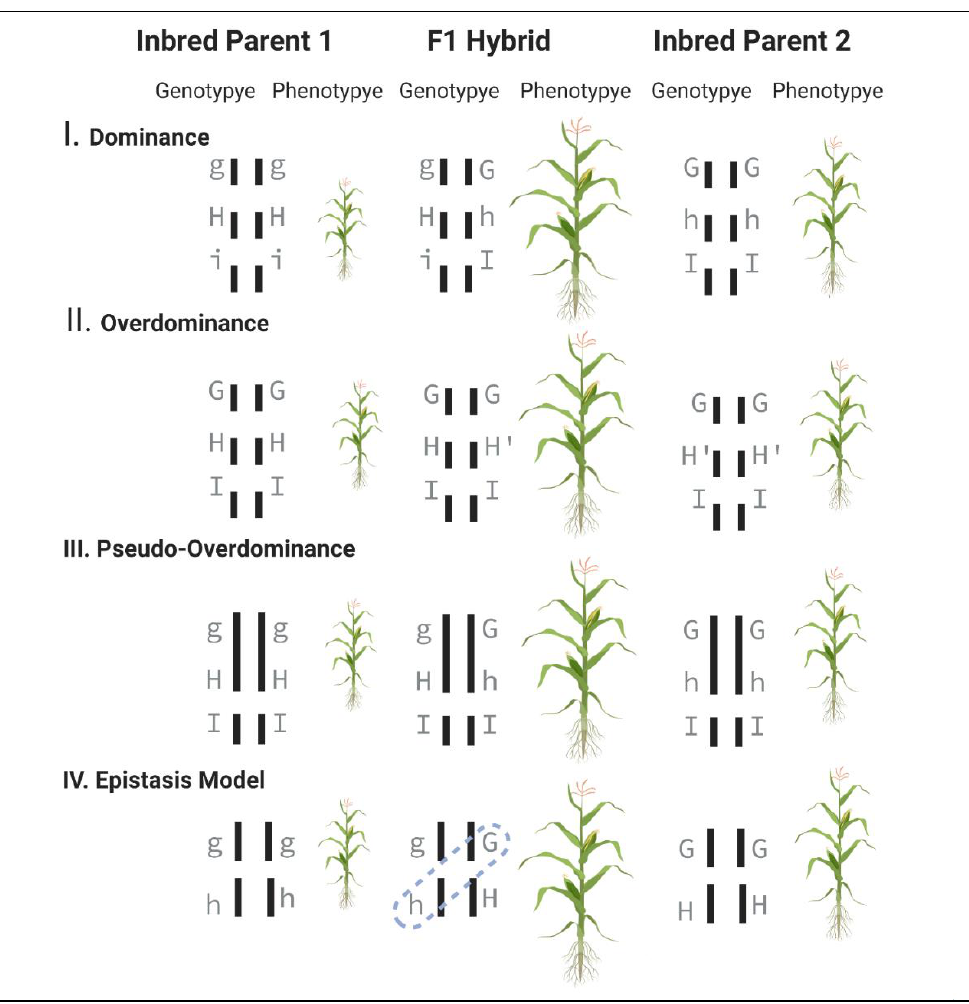
Figure 2. Genetic models for heterosis. Diagrams represent that the hypothetical phenotype or trait is influenced by multiple linked or unlinked loci (e.g., ‘g’, ‘h’, ‘i’). (I) Dominance Model : Inbred parents 1 and 2 exhibit marginally deleterious alleles in homozygous form (g and i in parent 1; h in parent 2). In F1 hybrid, complementation of superior alleles (G, H, I) occur at each locus resulting in a superior F1 phenotype. (II) Overdominance Model : Homozygous alleles at locus ‘h’ are different for both the inbred parents (HH and H’H’). In F1 hybrid, the interaction H and H’ produces a superior phenotype in comparison to both homozygous parents. (III) Pseudo-Overdominance Model : The superior performance of F1 hybrid is due to a small chromosomal region harboring two or more loci (e.g., g and h) linked in repulsion, in which the complementation of G and H is mimicking overdominance. (IV) Epistasis Model : The superior performance of F1 hybrid is due to the interaction between two different